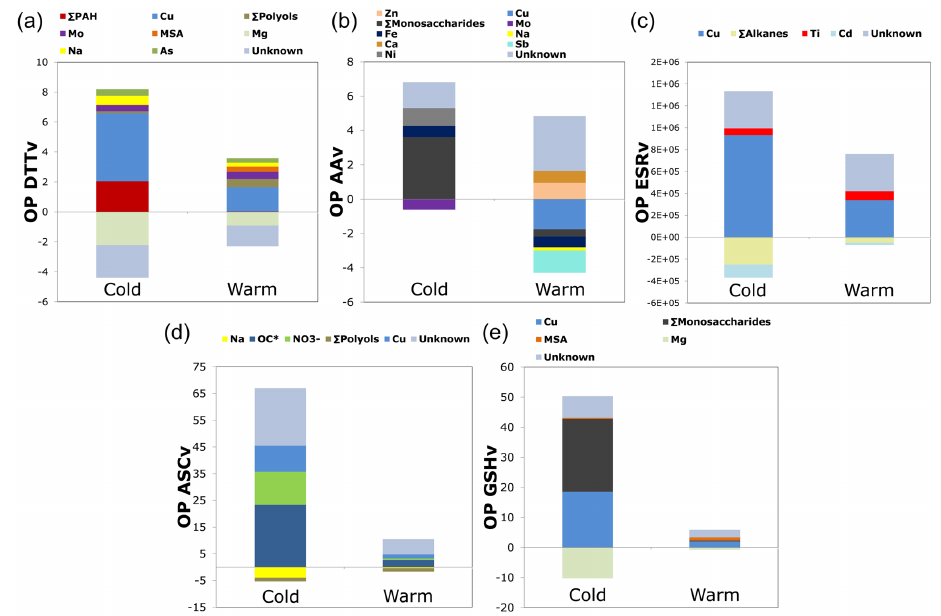
Figure 3. Multivariable linear regression analyses results. Contribution of predictors during cold and warm periods ( a , OP DTTv; b , OP AAv; c , OP ESRv; d , OP ASCv; e , OP GSHv). The intercepts, attributed to unknown species, were significantly > 0 in all models. Some species were assigned with negative contributions, explained by a weighting assignation of species so as to model OP differences between warm and cold periods or a possible antagonist effect of some atmospheric components on OP